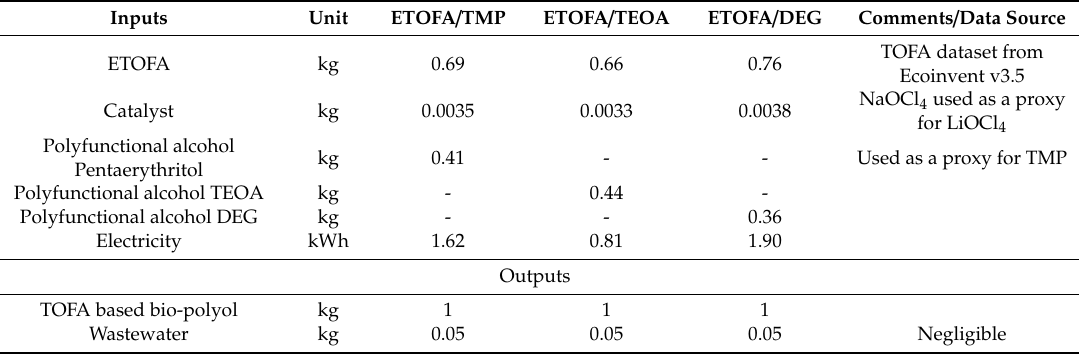
Table 2. LCI data for the production of 1 kg of TOFA based bio-polyol